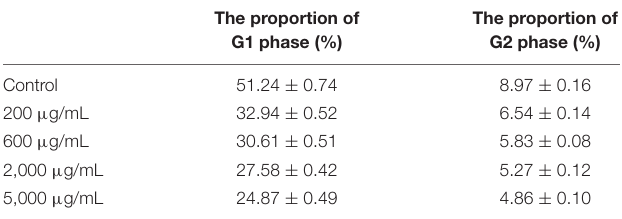
Values are mean ± SD of three different observations (n =